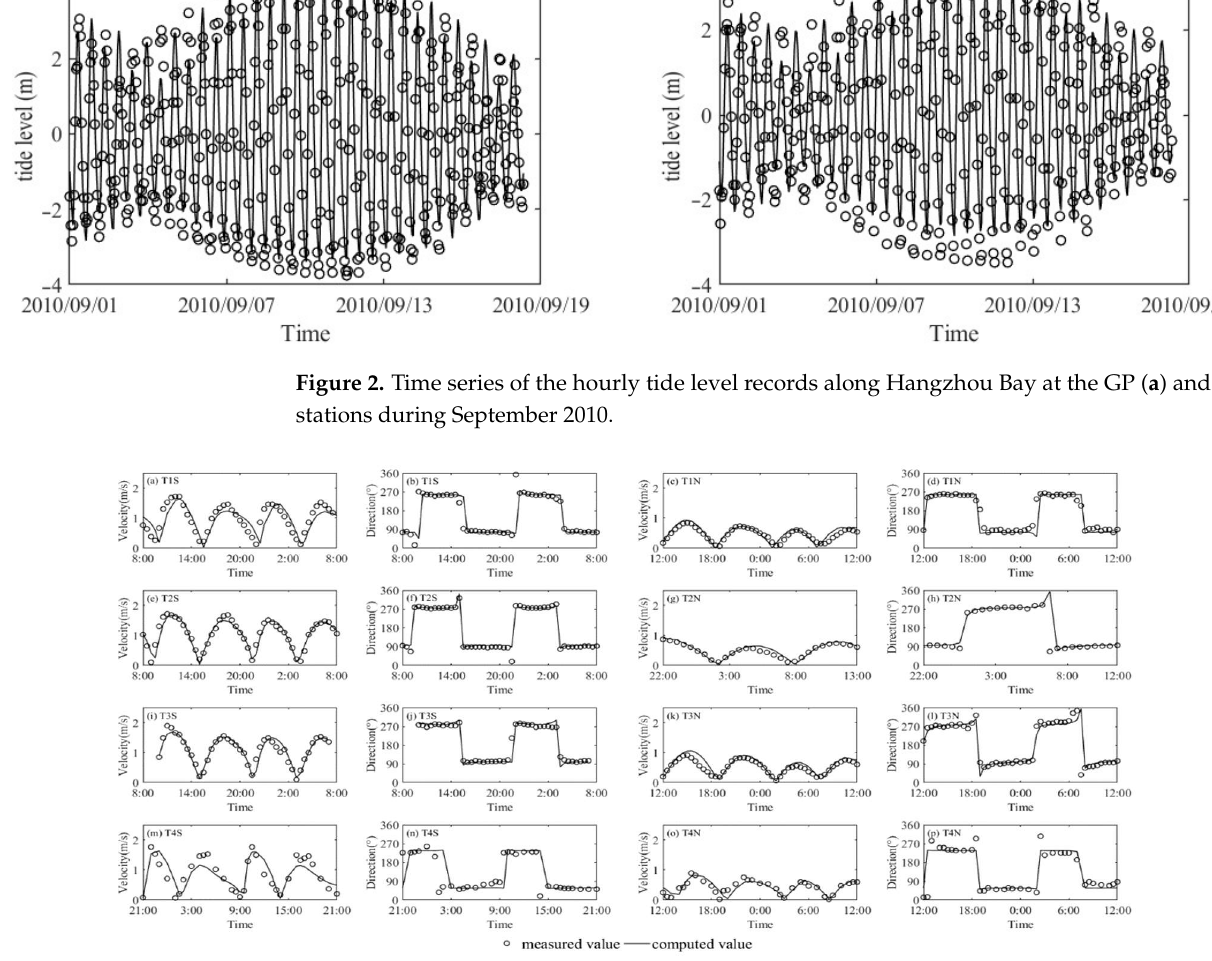
Figure 3. Comparison of the time series of the tidal velocity ( a , c , e , g , i , k , m , o ) and direction ( b , d , f , h , j , l , n , p ) at four tidal gauges of the spring tide (S) and neap tide (N) during September 2010. Table 2. Model observation data comparison statistics for the tide velocity